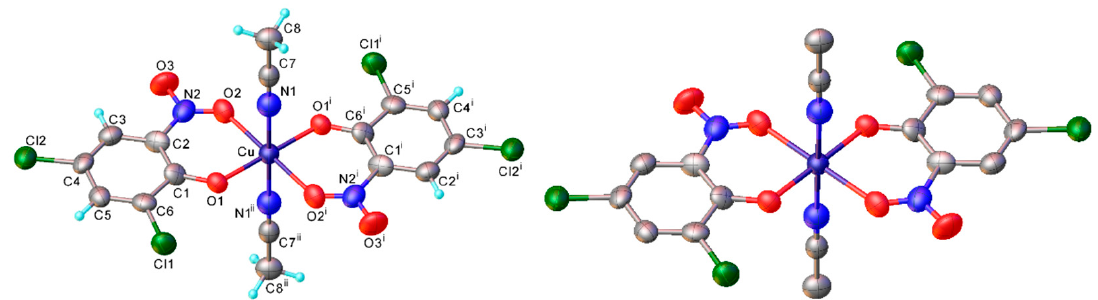
Figure 1. The molecular structure of copper bis (2,4-dichloro-6-nitrophenolato) di (acetonitrile) ( 2k ), shown both with ( left ) the hydrogen atoms simulated using riding models and without ( right ).